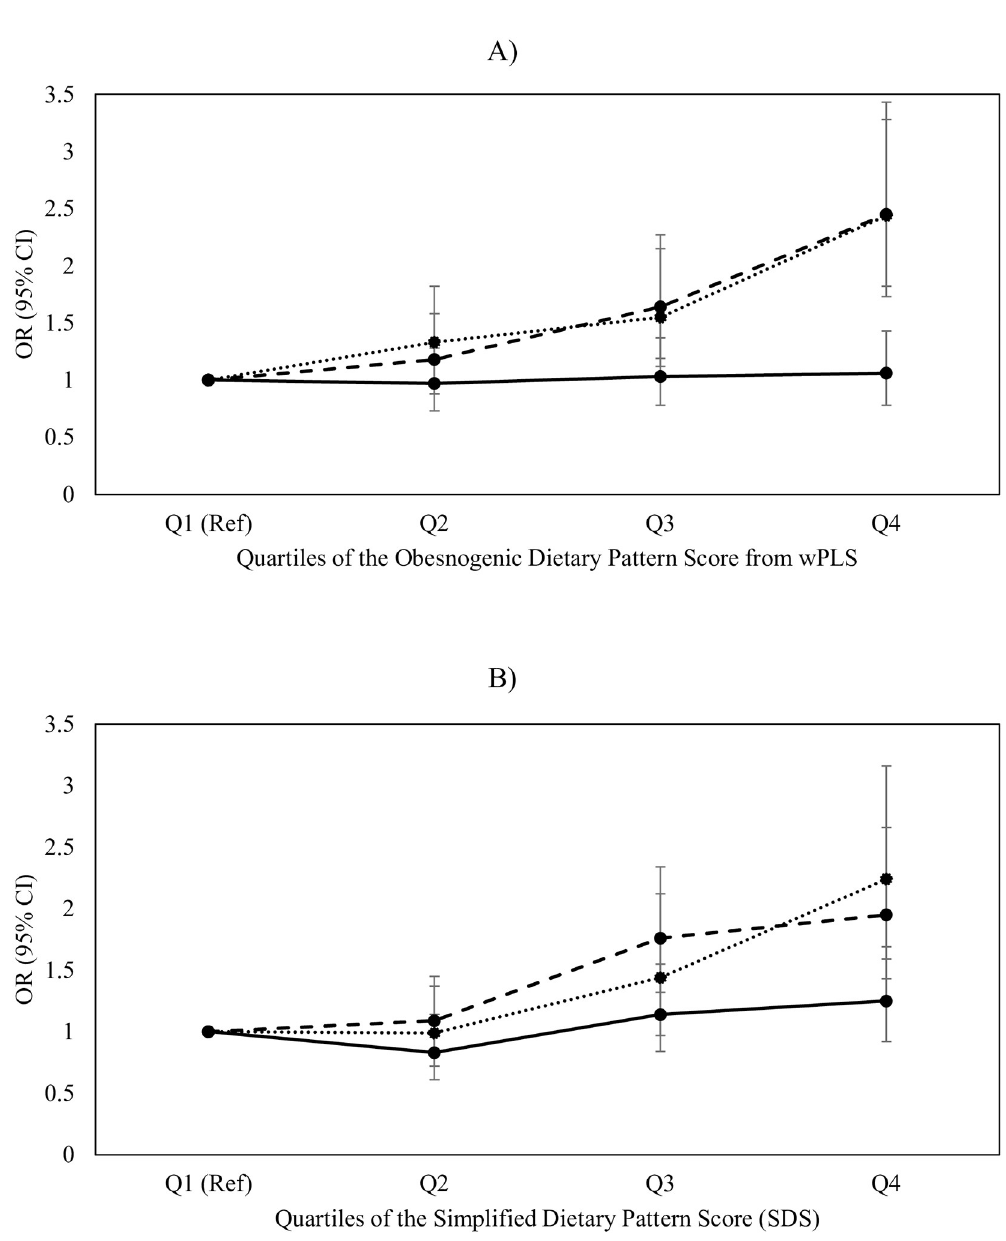
Fig 3. Multivariate-adjusted odds ratios (ORs) and 95% confidence intervals (CIs) for the joint classification of likelihood of obesity with � 1 self-reported chronic disease across quartile categories of A) the energy-dense, high-fat and low-fiber density (“obesogenic”) dietary pattern score from the wPLS (weighted partial least squares) model and B) simplified dietary pattern score (SDS) among Canadian adults from CCHS-Nutrition 2015 ( n = 12,049). Normal weight (BMI < 30 with � 1 chronic conditions = solid line; “Healthy obesity” (BMI � 30 with no chronic conditions = dashed line; “Unhealthy obesity” (BMI � 30 with � 1 chronic conditions) = dotted line. Q1 (“Healthiest”) was used as reference. All models were adjusted for age, sex, physical activity, smoking status and energy misreporting